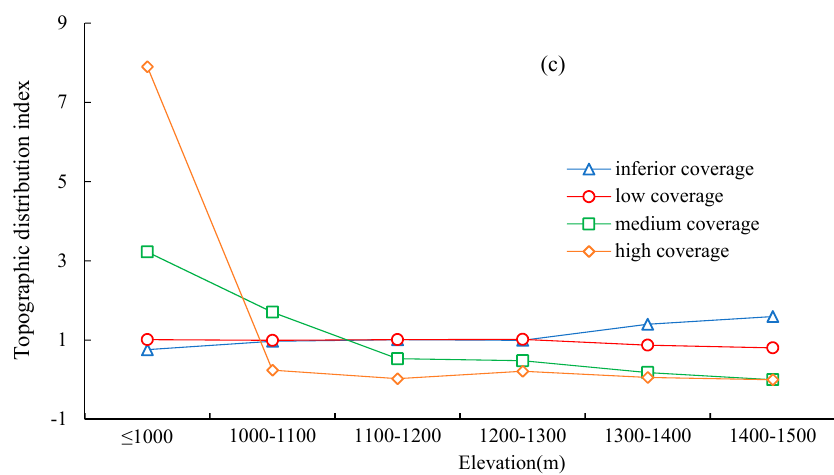
Figure 9. Variations in topographic distribution index and elevation in different fractional vegetation coverage levels. ( a ) Bare Pisha sandstone; ( b ) Sand-covered Pisha sandstone; ( c ) Soil-covered Pisha sandstone.